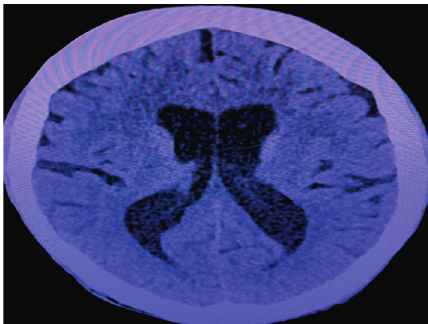
Figure 3: Dilated lateral ventricle consistent with